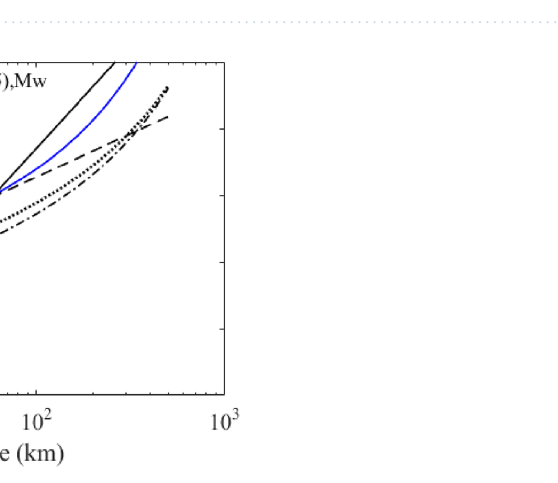
Figure 3. Distribution of liquefaction induced by Songyuan earthquake. We created this figure in using ArcGIS 10.0 (URL: http:// www. esri. com/).